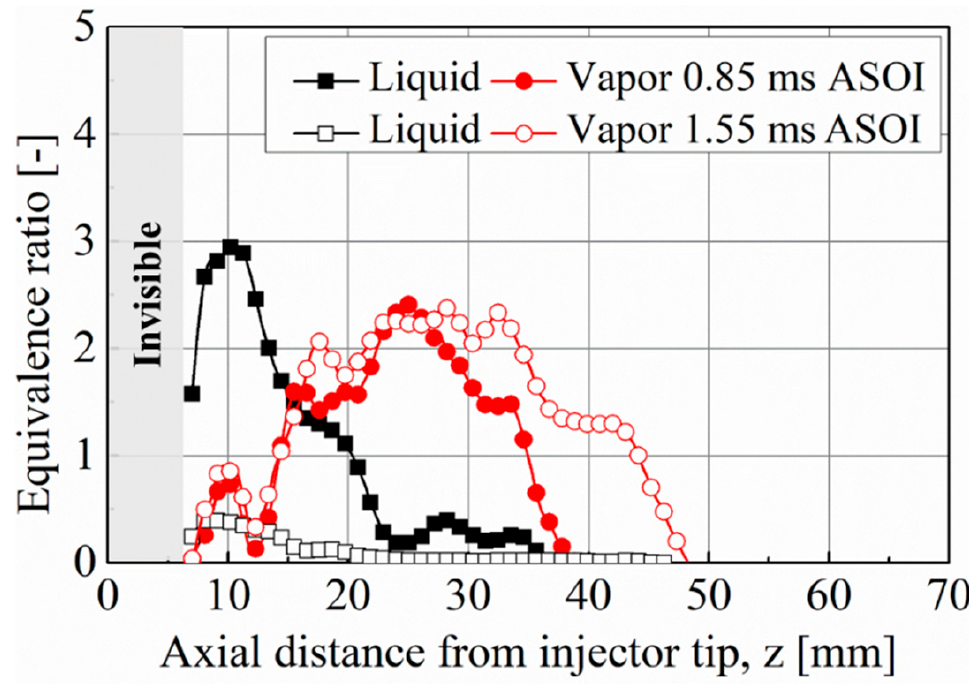
Figure 8. Axial distribution of liquid and vapor phases equivalence ratio (T a = 800 K, P a = 4.8 MPa, P inj = 100 MPa, M f = 5.0 mg).